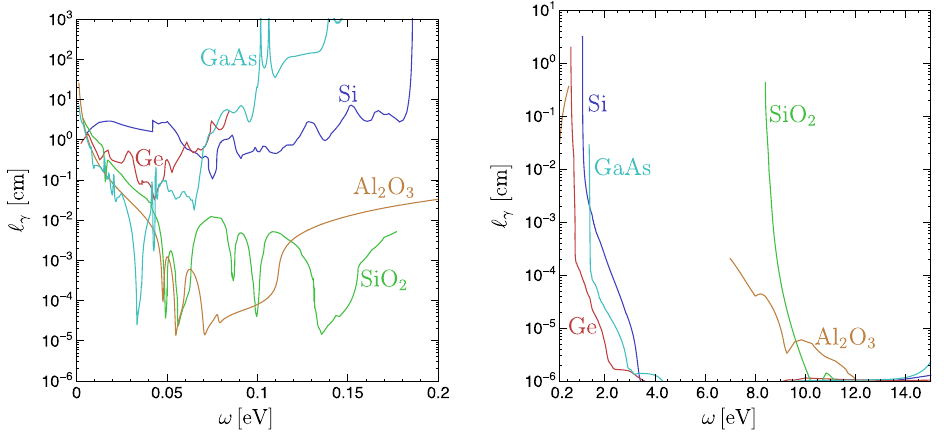
FIG. 8. Photon attenuation length [Eq. (2.8)] for photon energies 0 ≤ ω ≤ 0 . 2 eV (left) and 0 . 2 ≤ ω ≤ 15 eV (right), in different materials at room temperature. Data are taken from the same references given in Figs. 2 and 3. At energies very close to each material ’ s band gap, the attenuation lengths presented in this figure must be taken as only approximate. Precise band-edge absorption coefficients can be found in Refs. [125 – 129]. For some materials, a lack of data does not allow us to indicate precise photon attenuation lengths at some energies, so gaps in the figures are noticeable. For instance, for Ge a gap in coverage in the range 0 . 2 eV ≲ ω ≲ 0 . 6 eV is left between the data measured in Refs.